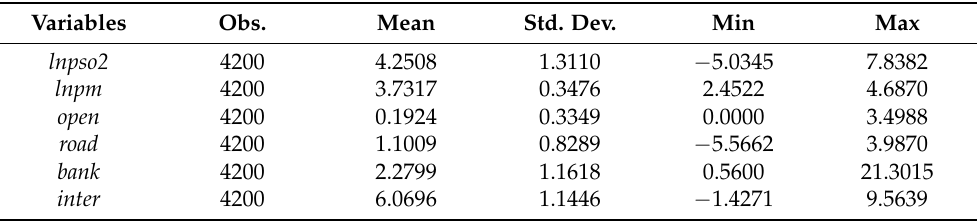
Table 1. Descriptive statistics of